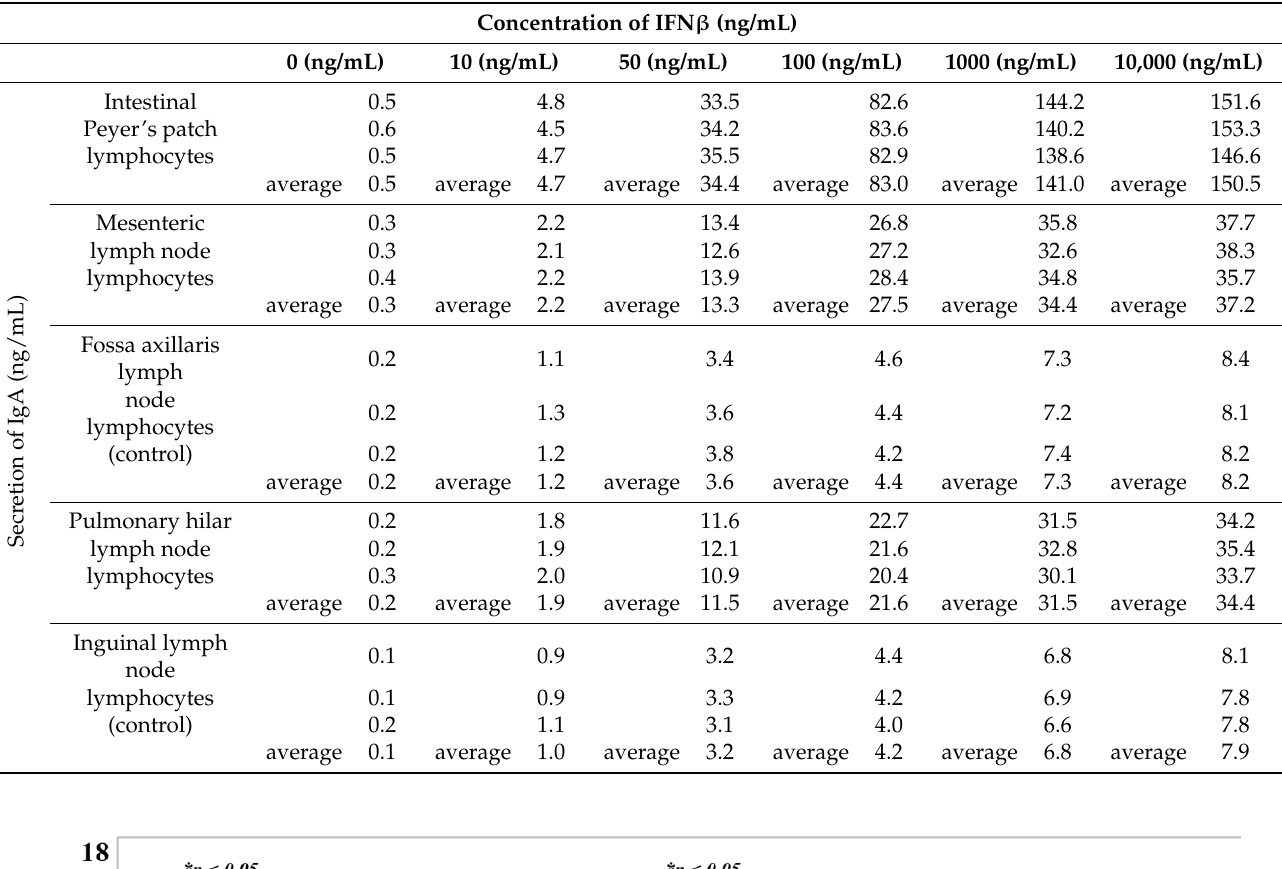
Table 5. Amounts of IgA secreted from various lymph node interstitial cells after addition of different concentrations of IFN β .